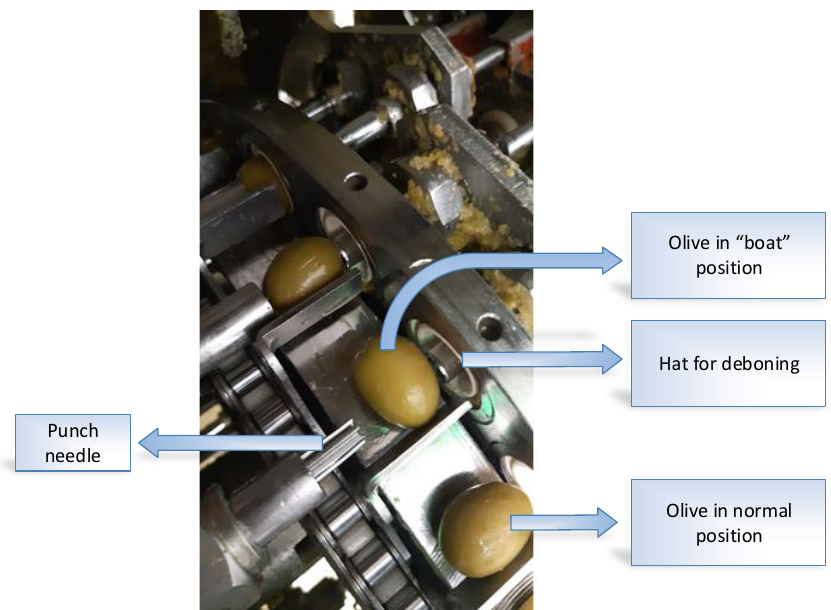
Figure 4. Punch needles in an olive pitting machine.